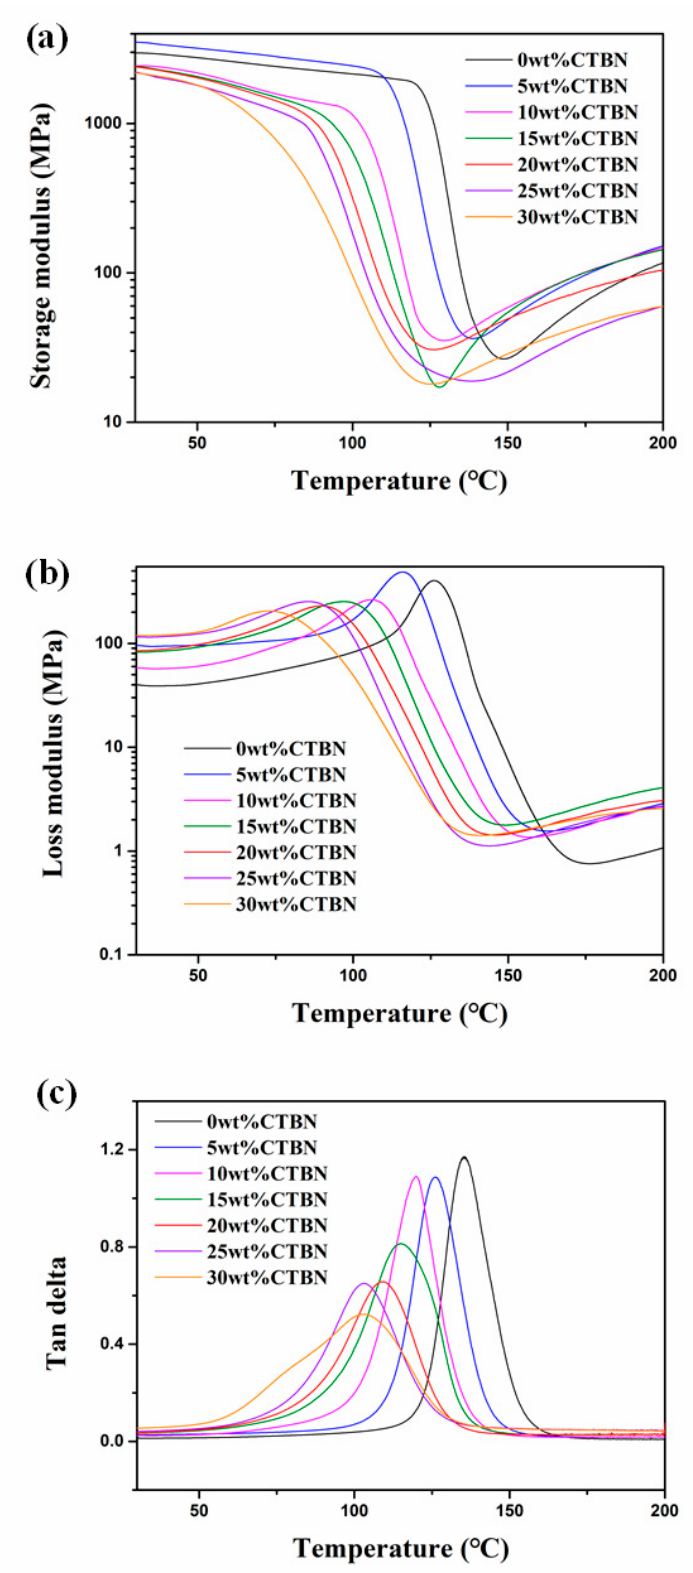
Figure 3. The dynamic mechanics analysis (DMA) patterns of composites with different CTBN contents: ( a ) storage modulus, ( b ) loss modulus, and ( c ) loss factor (tan δ ).